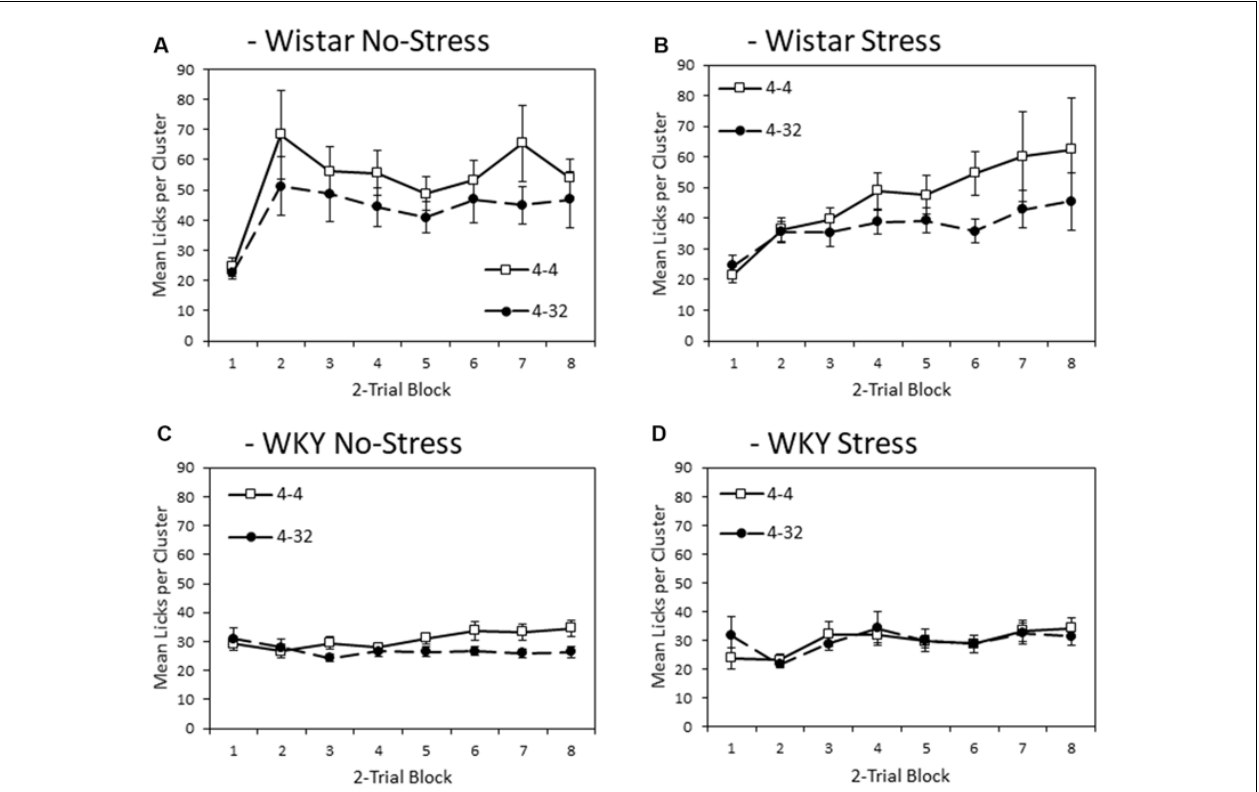
FIGURE 3 | Anticipatory contrast in mean lick cluster size (LCS: ± SEM) of the initially presented 4% sucrose solution as a function of whether it was followed by either 4% sucrose (open symbols) or 32% sucrose (filled symbols), separated by strain (Wistar: Panels A,B ; WKY: Panels C,D ) and stress groups (No-Stress: Panels A,C ; Stress: Panels B,D ). The data presented is averaged over two-day blocks. The solution was available for 3 min per day. WKY rats displayed a significantly lower mean lick cluster size than Wistar rats, but there was no effect of stress or stress × strain interaction. Critically, there was an anticipatory contrast effect (lick cluster size, indicating hedonic responses, for 4% sucrose was significantly lower when followed by 32% sucrose than 4% sucrose) and this effect was significantly reduced in WKY compared to Wistar rats (see “First Solution Lick Cluster Size—Anticipatory Contrast” section for details). Differential lick cluster sizes for the 4% solution depending on the subsequent concentration of sucrose solution offers a potential measure of anticipatory